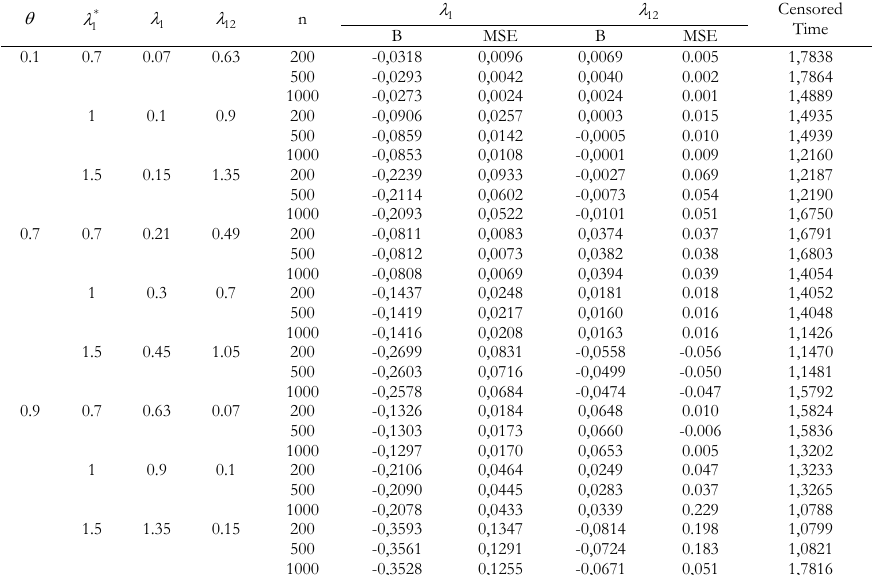
Estimates of the Weibull reliability parameters: censored